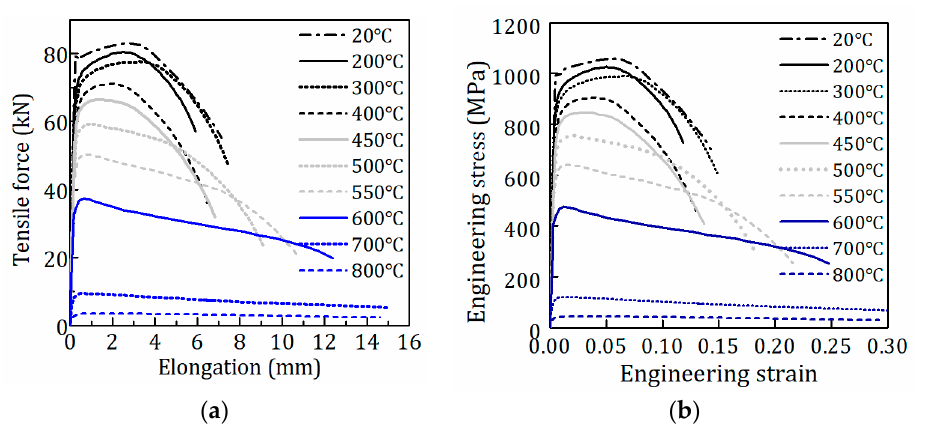
Figure 1. Geometry size of specimens (Unit: mm).